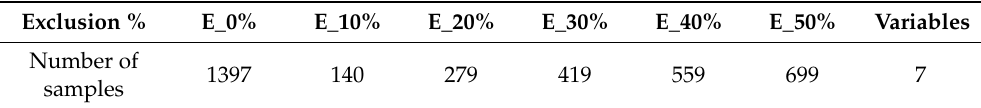
Table 1. Number of samples excluded for SOM imputation analysis.